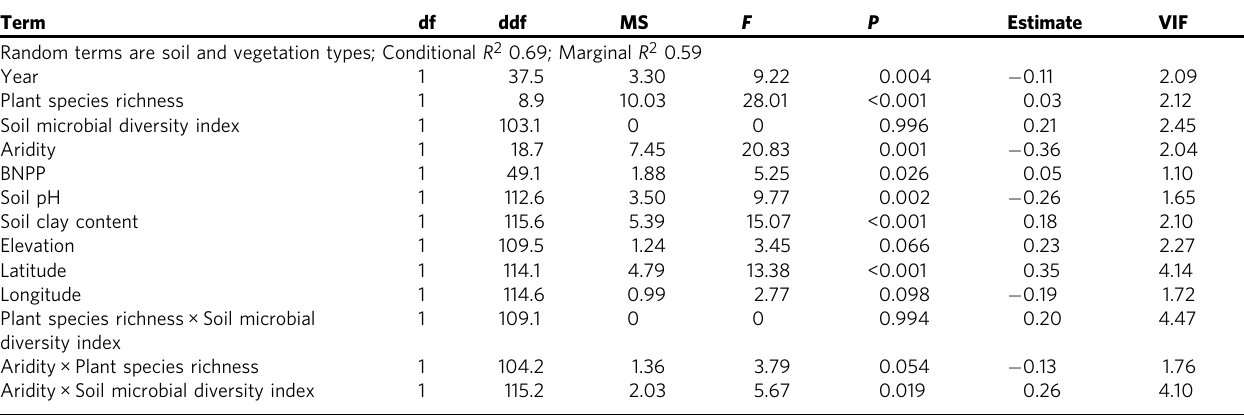
Table 1 Linear mixed-effects model for the relationships between multiple biotic (BNPP, plant species richness, and the soil microbial diversity index) and abiotic (aridity, soil pH, and clay content) factors and soil multifunctionality with considering soil and vegetation types as random